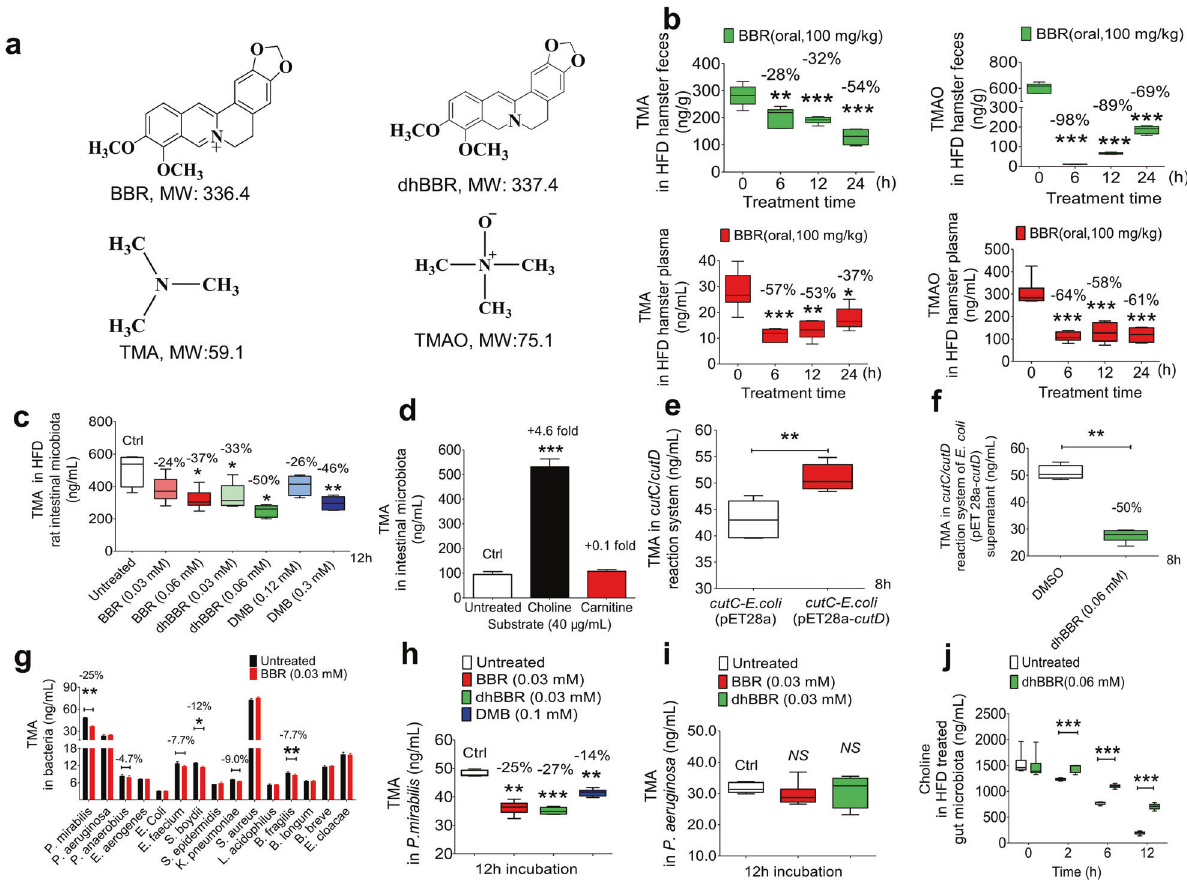
Fig. 1 BBR decreased the production of TMA/TMAO in gut microbiota. a Chemical structures of berberine (BBR), dihydroberberine (dhBBR), trimethylamine (TMA) and trimethylamine- N -oxide (TMAO). b The levels of TMA and TMAO in faeces or plasma of the HFD-fed hamsters were signi fi cantly reduced 6, 12, and 24 h after oral administration of BBR (100 mg/kg, n = 6, * P < 0.05, ** P < 0.01 and *** P < 0.001). c BBR, dhBBR (0.03, 0.06 mM) inhibited the production of TMA in the intestinal bacteria from HFD-fed SD rat, and the inhibitory effect of dhBBR was stronger than that of 3,3-dimethyl-1-butanol (DMB, 0.12, 0.3 mM), a positive control, after 12 h incubation ( n = 6, * P < 0.05, ** P < 0.01, *** P < 0.001). d A 4.6-fold increase of TMA was observed after addition of choline; but the phenomena was not seen with carnitine (40 μ g/mL, n =